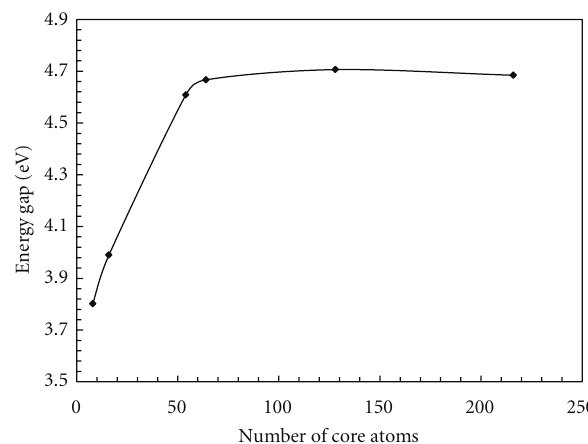
Figure 2: Energetically optimized zb-AlP core lattice constant as a function of the number of atoms in the core.